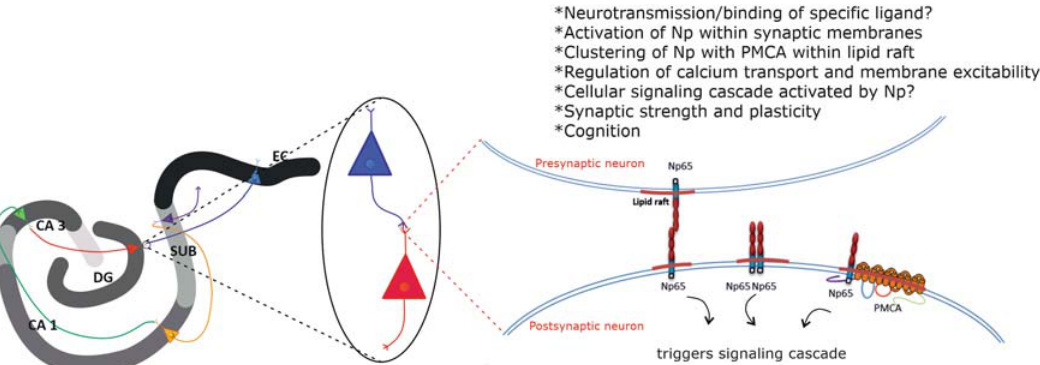
Fig. 1 Hypothethical representation of functionally associated lipid raft residents — neuroplastin and plasma membrane calcium ATPase — and their involvement in molecular basis of cognition. Np, neuroplastin; PMCA, plasma membrane calcium ATPase; CA, Cornu Ammonis; DG, dentate gyrus; SUB, subiculum; EC, entorhinal